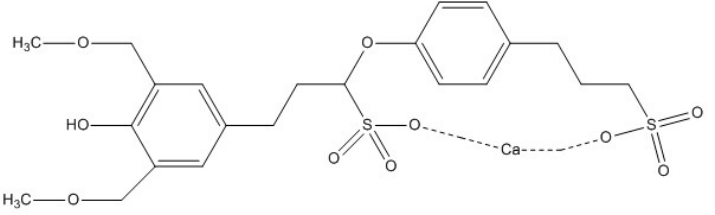
Figure 1. Chemical structure of calcium lignosulfonate (CLS) [1,23].